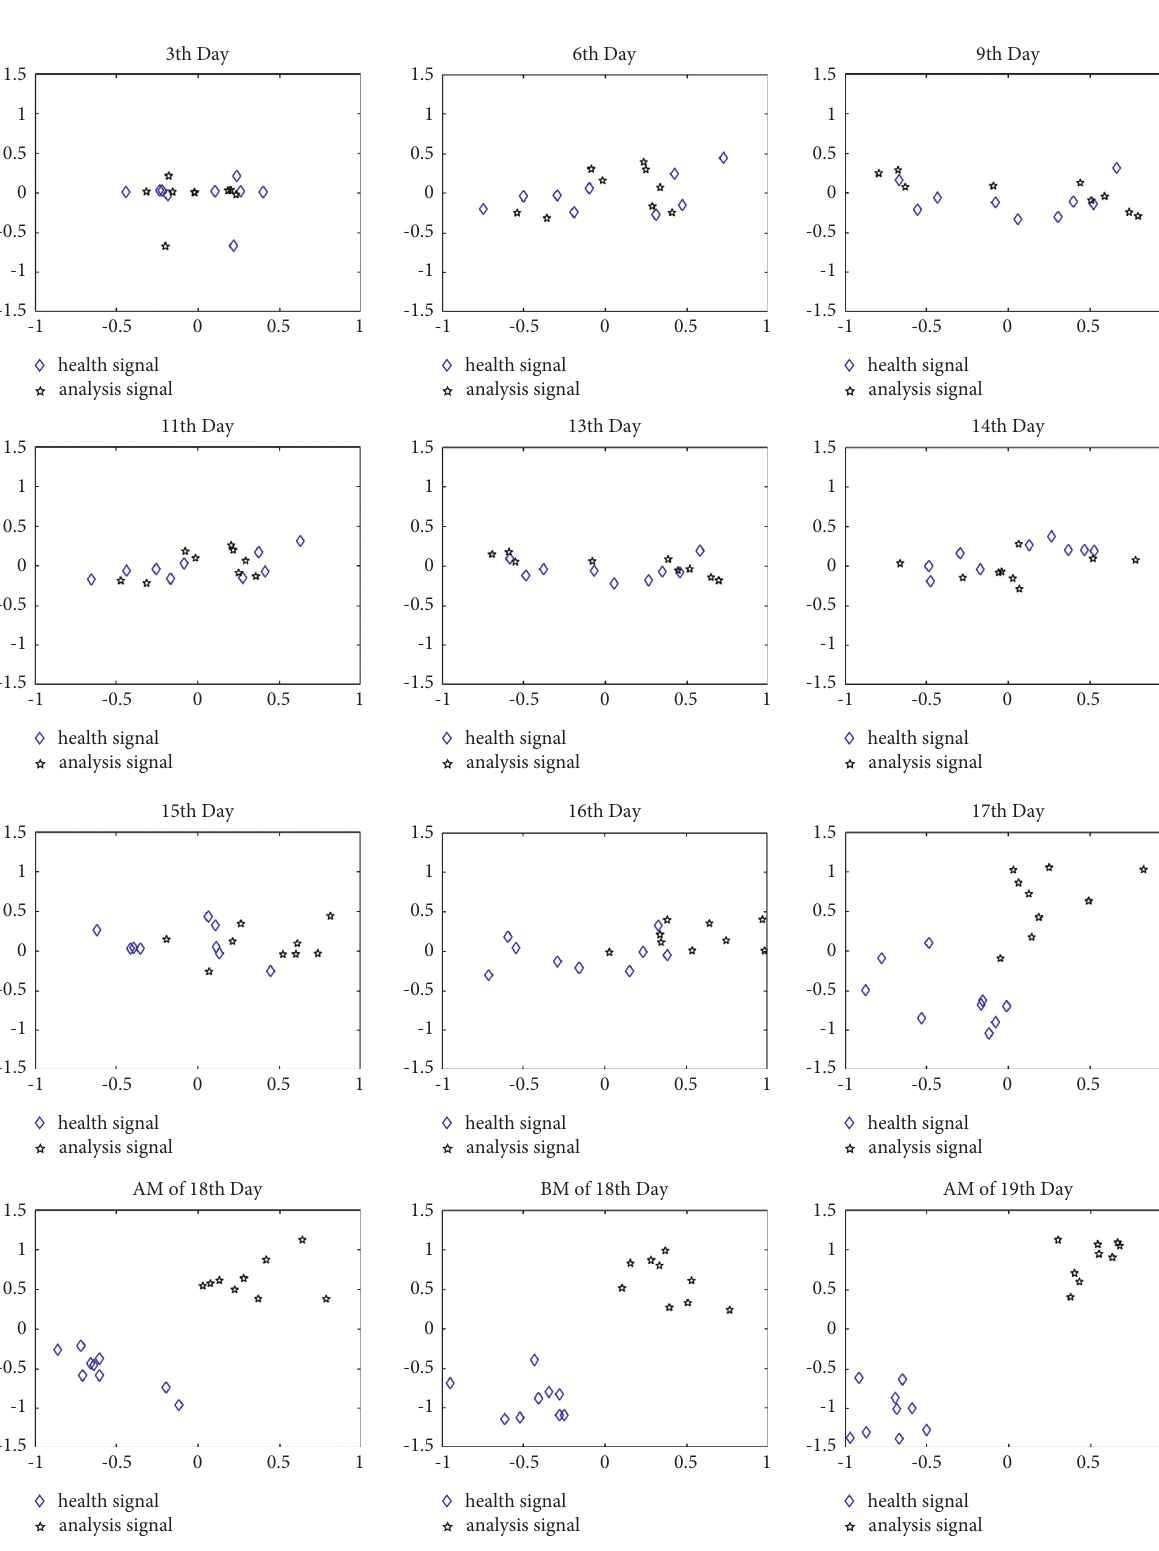
Figure 9: LLE analysis result. ◊ : low-dimensional spatial characteristics of health comparison signals after LLE processing; ✫ : low-di- mensional spatial characteristics of analysis signals after LLE